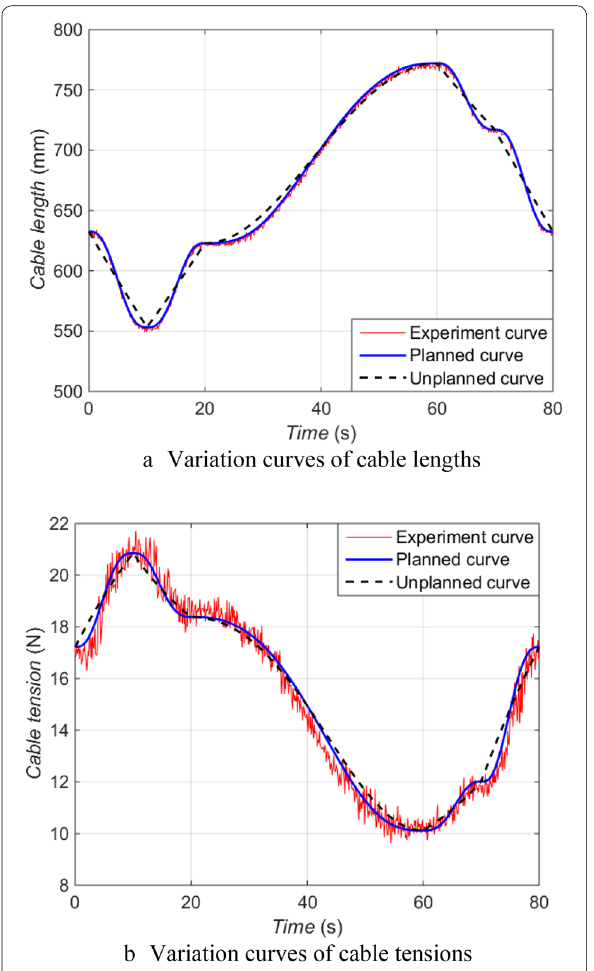
Figures 18(b), 19(b), and 20(b), respectively. The red solid line denotes the experiment curve, the blue solid line